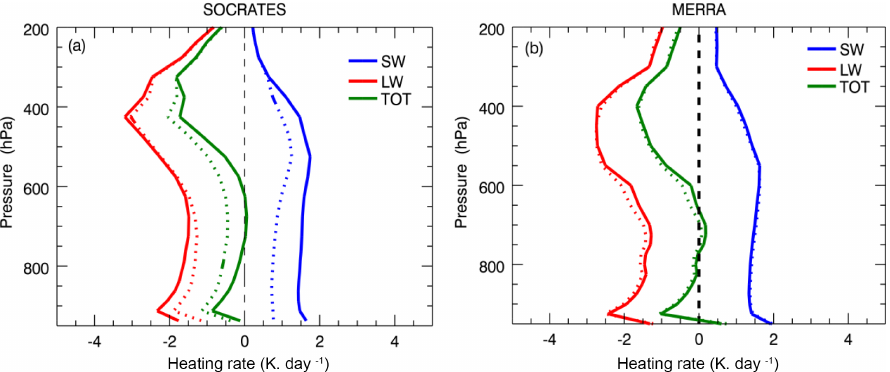
Figure 12. Mean radiative heating rate profile for 8–30 June 2011 at BBM. (a) Results from nDnC (dashed lines) and wDnC (solid lines) using the Fennec profile and (b) MERRA model output for all-sky (solid lines) and clear-sky (dashed lines)